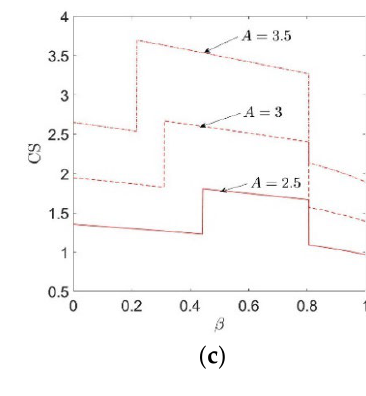
Figure 7. Impacts of β and ( a ) t ( b ) δ ( c ) A on CS